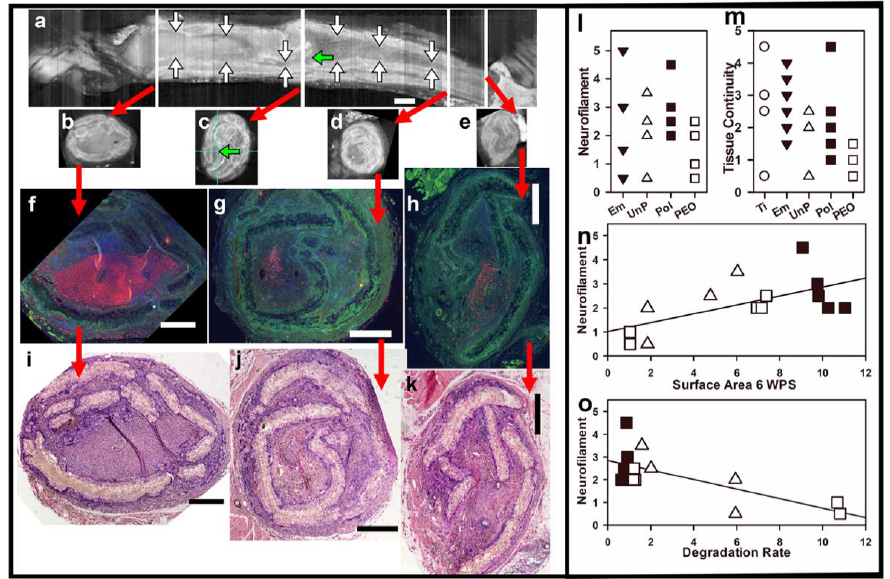
Figure 8. ( a – k ) Comparison between micro-CT and tissue histology from one Pol group animal. In Micro-CT images ( a – e ), conduit pieces look like double white lines and tissues have varied shades of gray (water is black). Breaks can be seen in the conduit and no Mg metal was detected. ( a ) In a longitudinal view, a continuous pathway (tissues between white vertical arrows) is seen from proximal (left) to distal ends. ( b – e ) Axial images were taken at the white lines shown in ( a ), as indicated by red arrows. Horizontal green arrows in ( a , c ) point to one of the narrowest tissue strands (blue grid lines cross in 8c on the tissue strand indicated by the green arrow). Bars are 1 mm for ( a – e ). In ( f – h ), paraffin sections matched to the micro-CT slices were immunostained for axons (anti-NF, red) and nuclei (blue) (green non-specific staining is shown to aid visualization of tissues). In ( i – k ), adjacent sections were stained with H&E. Magnification bars in ( f – k ) are 0.5 mm. Graphs ( l – o ): In ( l ) NF scores per group, ( m ) tissue continuity per group. ( n ) NF scores calculated at 14 WPS correlated with SAs at 6 WPS. ( o ) NF scores correlated with DRs at 6 WPS. Symbols are in Figure